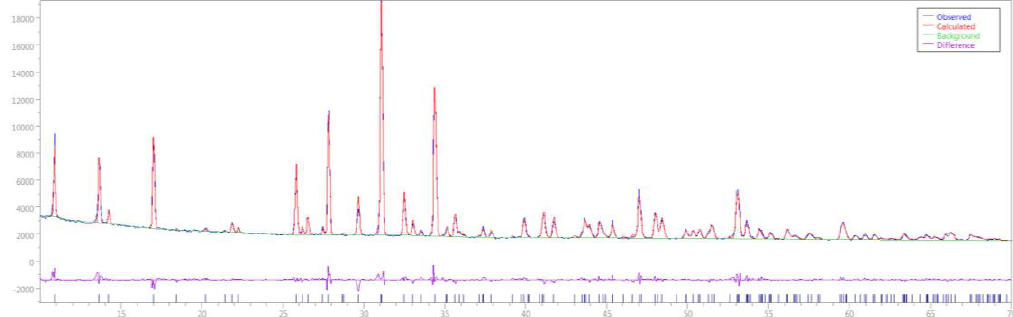
Figure 2. Rietveld plot of Ca 9 Dy(PO 4 ) 7 : observed diffraction profile (blue line); calculated profile (red line); difference profile (violet line); background (green) [64].